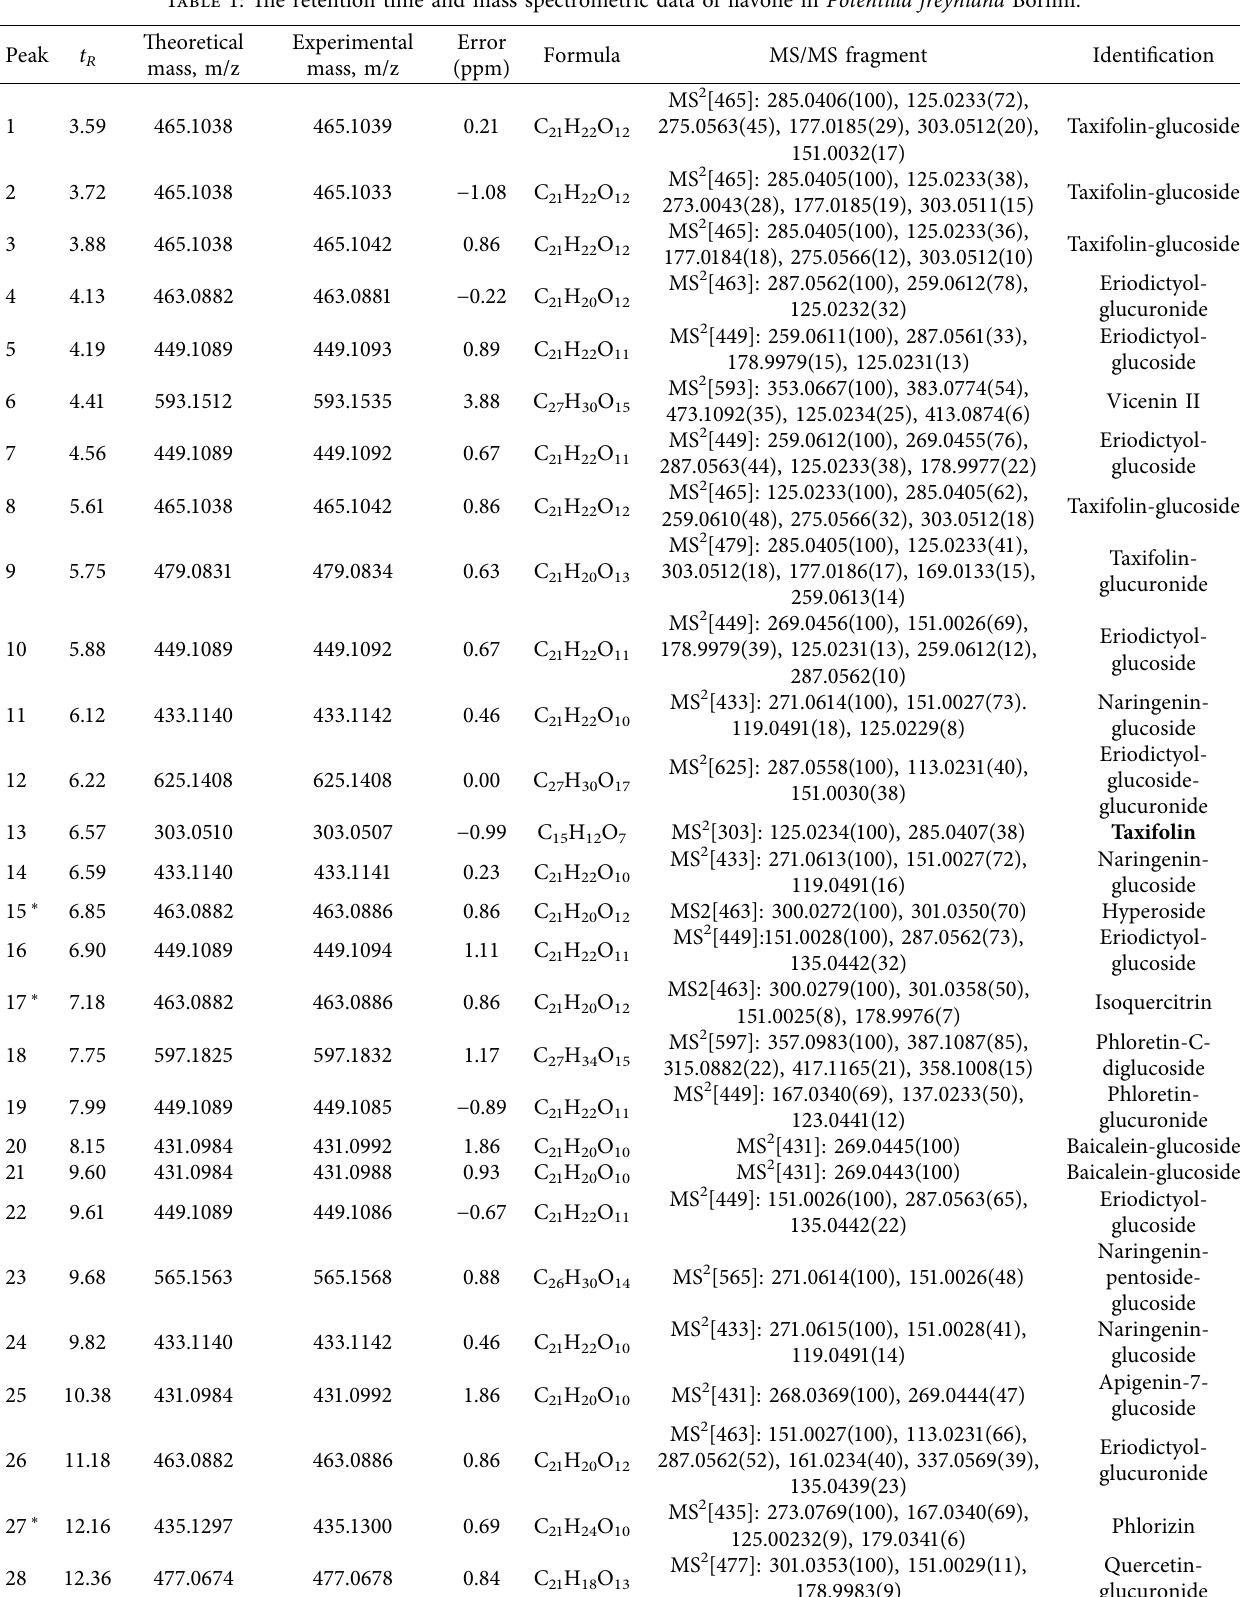
Table 1: The retention time and mass spectrometric data of flavone in Potentilla freyniana Bornm.